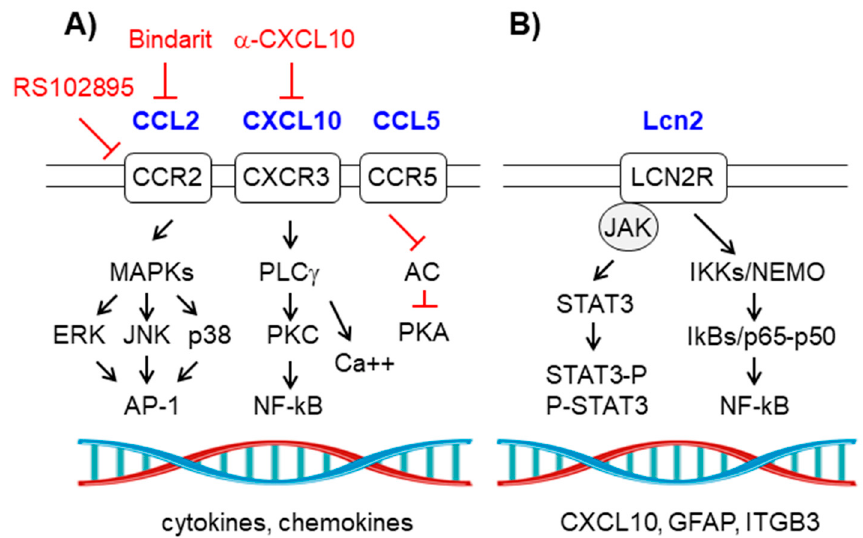
Figure 5. ( A ) Chemokine signaling pathway. CCR2, CCR5, and CXCR3 belong to the group of G-protein coupled receptors (GPCRs). Schematic view of the components of the signaling pathway; see text for details. Components of the pathway that are increased in epilepsy are in blue. Therapeutic strategies to prevent the pathway are in red. ( B ) Lcn2/LCN2R signaling pathway. Schematic view of the components of the pathway. See text for details. Components of the pathway that are increased in epilepsy are in blue. Pointed arrows indicate direction of the signaling pathway. Blunt arrows indicate inhibition.